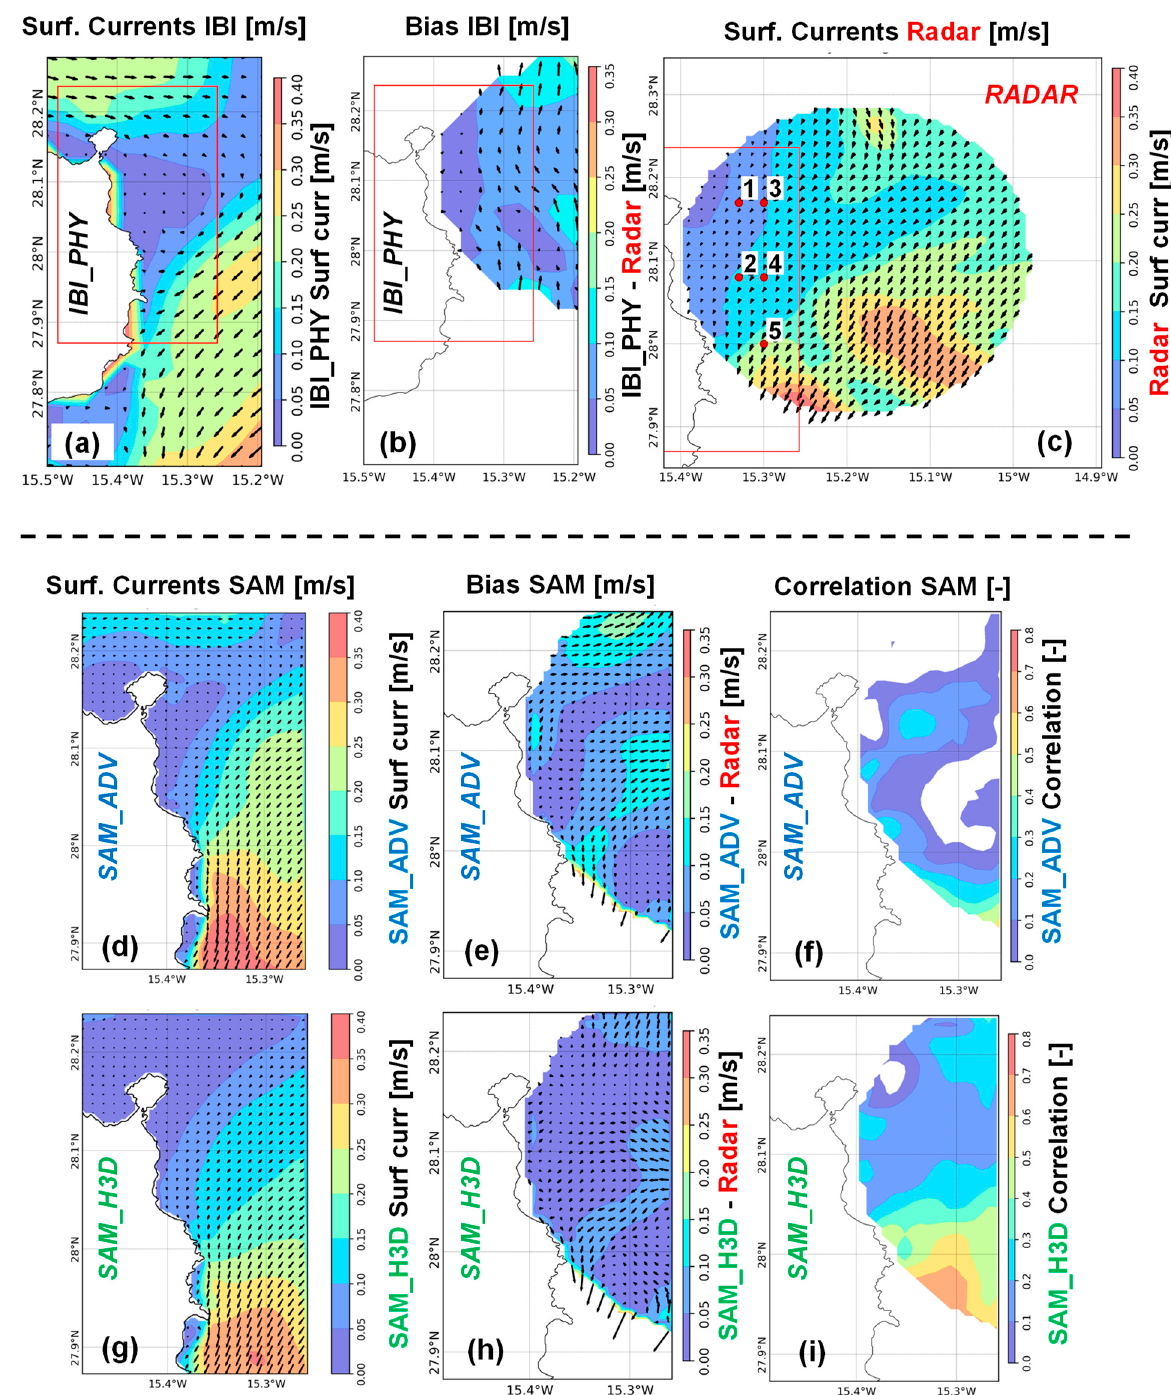
Figure 7. HF Radar vs model solutions (SAM_H3D and SAM_ADV experiments, together with the Copernicus IBI_PHY parent solution) at Gran Canaria during September 2020. Monthly ‐ averaged surface current field modelled and observed, depicted at subpanels ( a ) (IBI_PHY) ‐ ( d ) (SAM_ADV) ‐ ( g ) (SAM_H3D), joint with ( c ) (HF Radar), respectively. However, the error metrics subpanels ( b , e , f , h , i ) are computed from hourly ‐ averaged fields. Model ‐ observation monthly biases for IBI_PHY, SAM_ADV and SAM_H3D are depicted in the central column (subpanels b , e , h ); SAM_ADV and SAM_H3D model correlation fields with HF Radar observations are shown in subpanels ( f ) and ( i ). Units in m/s. The red rectangle in subpanels ( a – c ) the SAMOA coastal domain. Red dots at subpanel ( c ) represent locations where time series metrics are computed (summarized in Table 5).